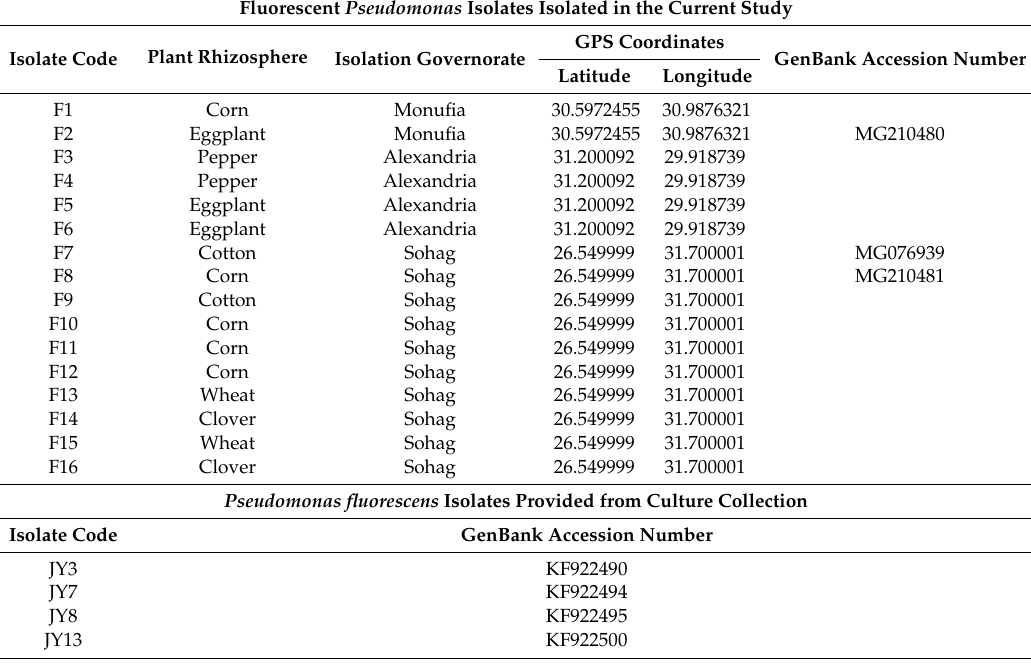
Table 1. Fluorescent Pseudomonas isolates used in the current study. Fluorescent Pseudomonas Isolates Isolated in the Current